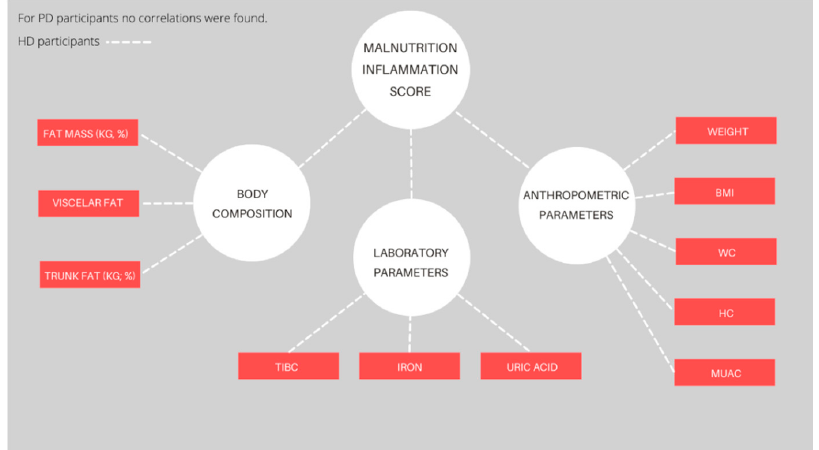
Figure 2. Significant correlations of the Malnutrition Inflammation Score and measured parame-